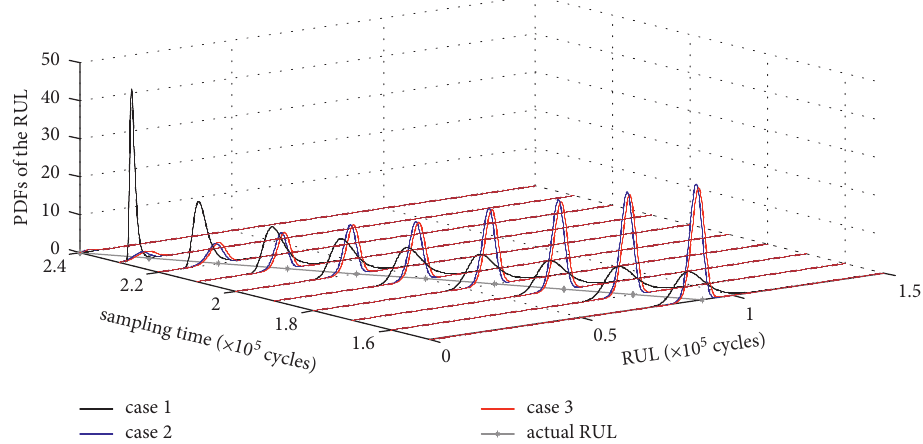
Figure 5: Comparison of the PDFs of the RULs for Cases 1–3 of the fatigue crack propagation